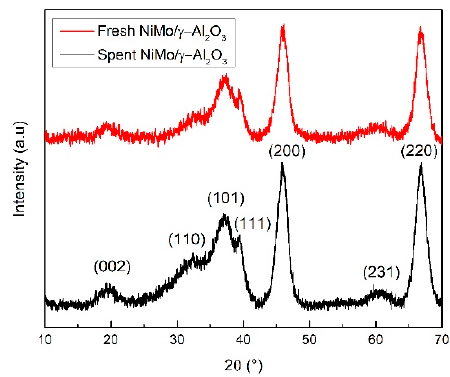
Figure 5. XRD pattern for fresh and spend NiMo/ γ‐ Al 2 O 3 .